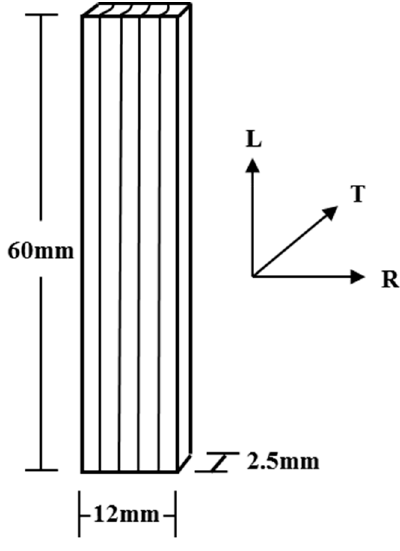
Figure 1. Schematic of wood specimen.